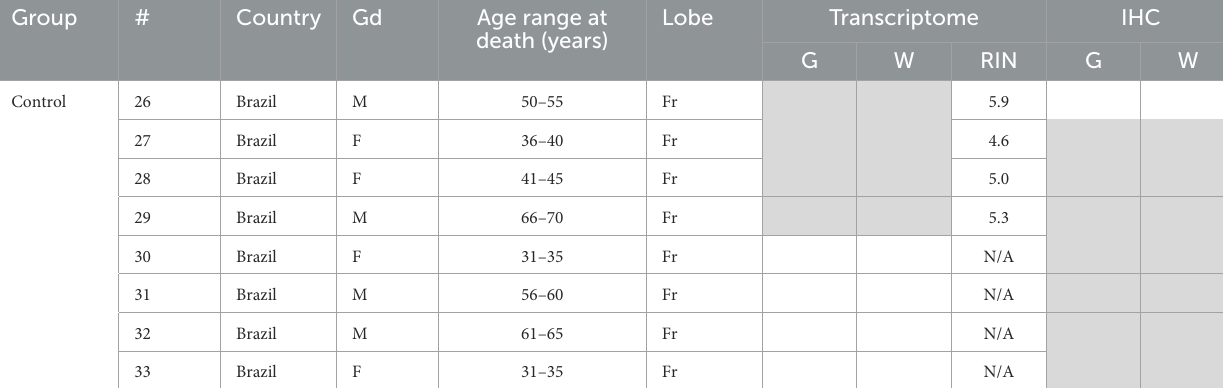
TABLE 2 Clinical data of the controls, whose samples were submitted for transcriptome analysis and/or immunohistochemical validation.